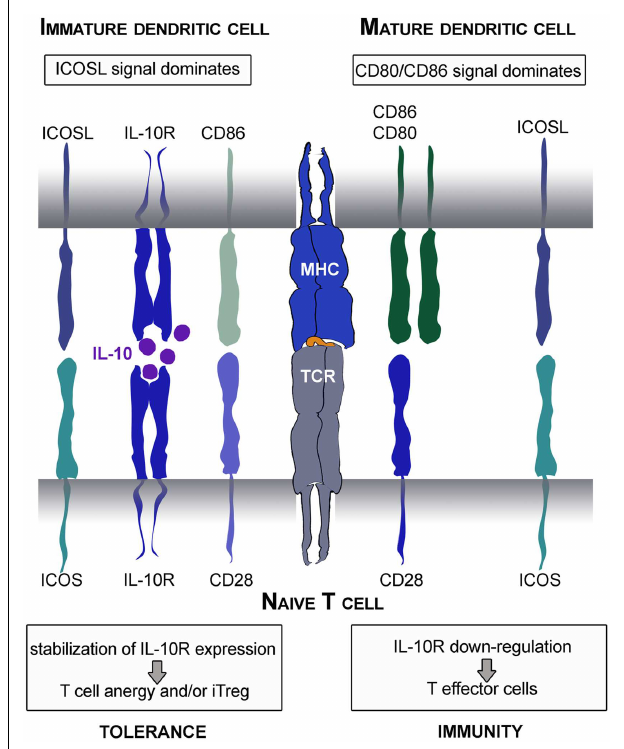
FIGURE 4 |Tolerogenic or immunogenic function of ICOS/ICOSL interaction depends on CD28 signaling. Immature DC express low amounts of CD28 ligands and thereby provide strong ICOS signals.This leads to stabilization of IL-10R on the surface of stimulated naïveT cells. Subsequently, the immunomodulatory cytokine IL-10 produced by DC mediates its function resulting in the differentiation into anergicTreg. In contrast, mature DC provide strong CD28 signals that overcome the tolerogenic ICOS function resulting in stabilization of IL-2 mRNA and synthesis and thereafter, the differentiation into inflammatoryT effector